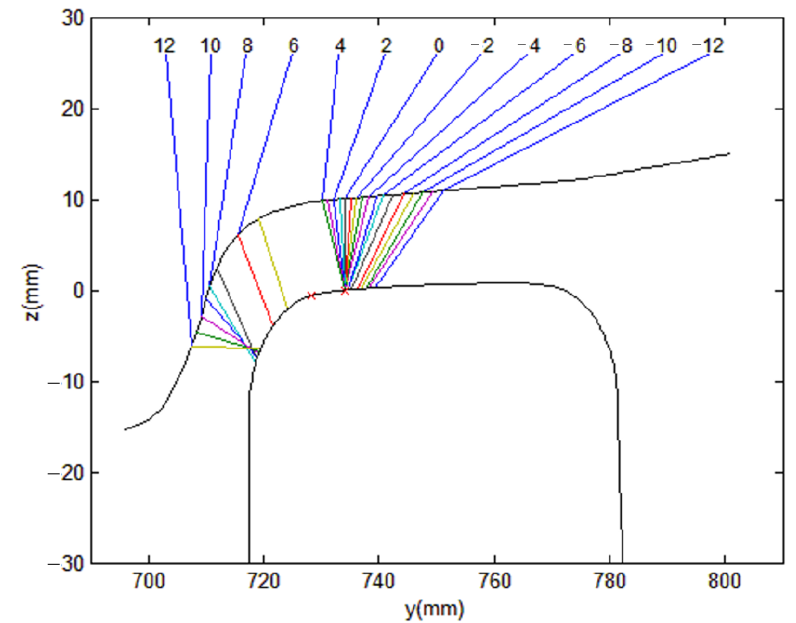
Figure 8. Position of contact points on wheel and rail depending on lateral displacement of wheelset (initial wheel profile).